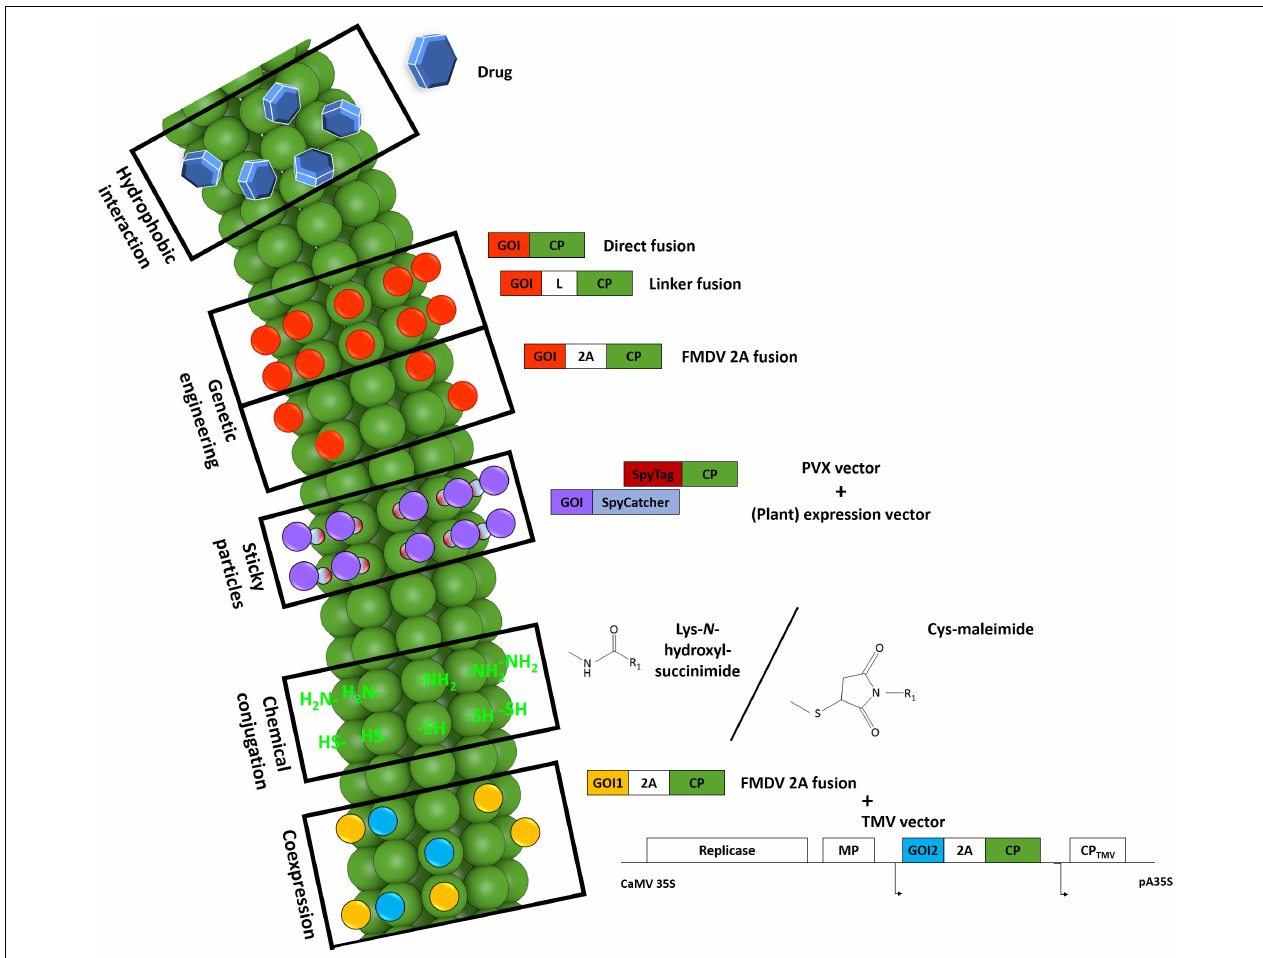
FIGURE 2 | Schematic representation of modifications evaluated for the production of PVX-based VNPs. Certain drugs (blue hexagons) such as doxorubicin can intercalate between the coat protein (CP) subunits of particles via hydrophobic interactions (Le et al., 2017b; reproduced by permission of The Royal Society of Chemistry). By genetic engineering, it is possible to fuse a target sequence to the 5 (cid:48) -end of the cp gene as a direct fusion, with an additional linker, or with an intervening 2A sequence. This strategy leads to the production of particles carrying the protein of interest (red) on every CP copy as direct fusions or on ∼ 25% of the CP copies with the 2A sequence. The fusion of a SpyTag peptide (dark red) to the particle surface makes it possible to attach any protein of interest (purple) fused to a SpyCatcher protein (light blue) expressed in any system. The PVX particle surface also features reactive groups (bright green) offered by lysine and cysteine residues that can be used for the chemical coupling of target molecules (R 1 ). N -hydroxysuccinimide or maleimide chemistry is typically used for this purpose. For the successful presentation of several large proteins utilizing the 2A sequence (yellow), a second set of a PVX CP fusion constructs (blue) can be co-expressed in the same cell by co-infection with a TMV vector. 2A, Foot-and-mouth disease virus 2A sequence. CaMV 35S/pA35S, Cauliflower mosaic virus 35S promoter/polyadenylation sequence. CP, coat protein. GOI, gene of interest. L, linker. MP, movement protein. Small arrows indicate subgenomic promoter-like sequences. Adapted from Le et al.